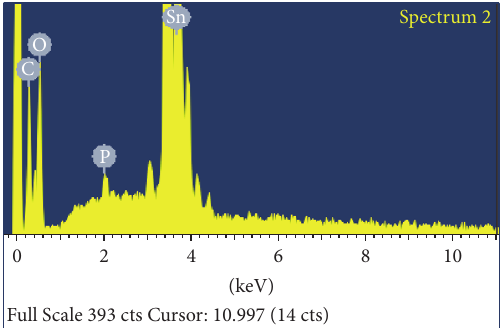
Figure 4: EDX spectrum of SnO 2 @ phenyl-phosphonic acid